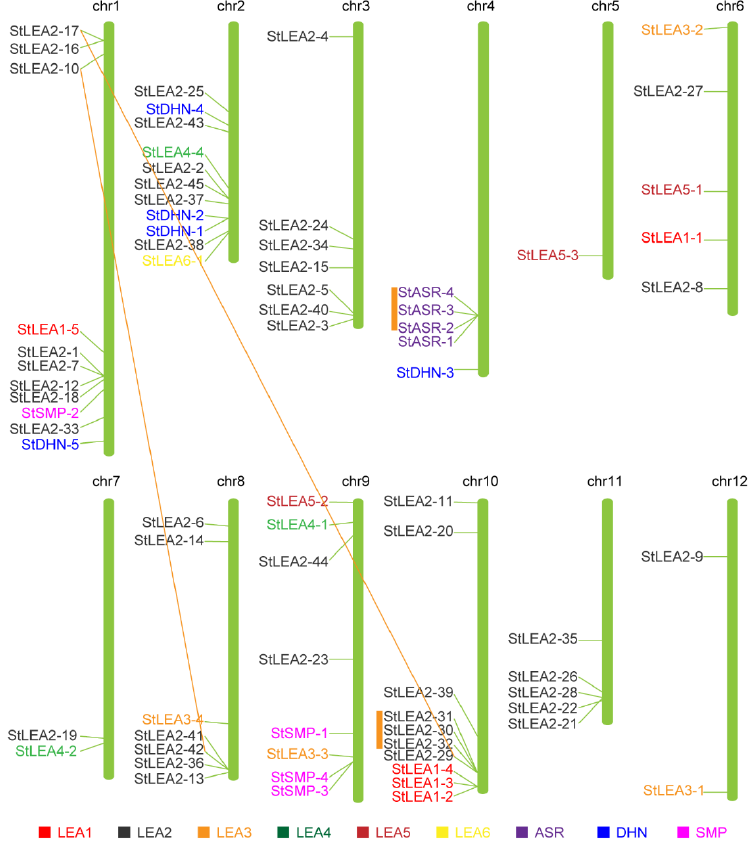
Figure 3. Distribution of Solanum tuberosum LEA ( StLEA ) gene family members on potato chromosomes. The genes at two ends of orange lines mean the potential partial duplicated gene pairs. The orange bar indicates the tandem repeated genes. StLEA1 , StLEA2 , StLEA3 , StLEA4 , StLEA5 , StLEA6 , StASR , StDHN and StSMP subgroup are presented in red, black, orange, dark green, dark red, yellow, purple, blue and pink.